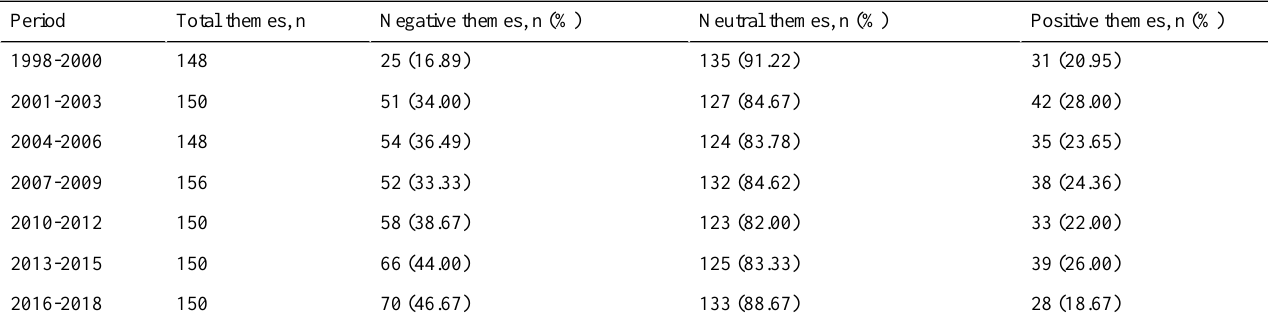
Table 1. Frequency of negative, neutral, and positive themes in lyrics based on 3-year intervals.